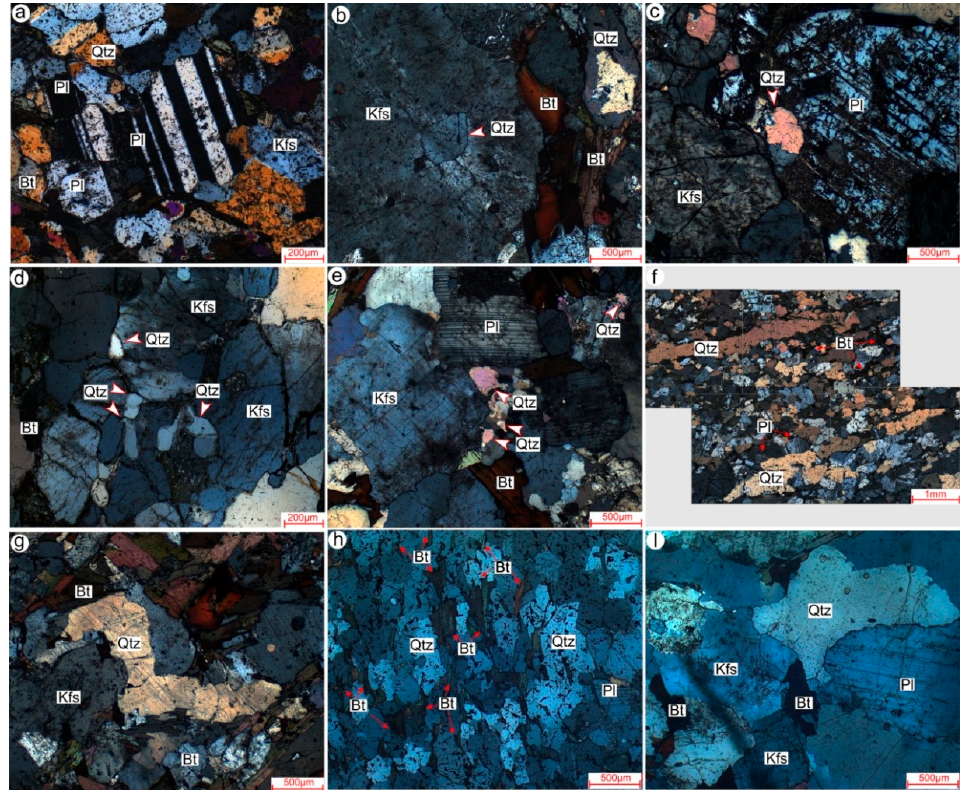
Figure 5. Microstructures of the Fuhuling metatexite, diatexite, and biotite monzogranite. ( a ) Microcracks in plagioclase in the metatexite. ( b,c ) Interstitial quartz at grain boundaries or within microcracks of K-feldspar in metatexites (arrows). ( d ) String of beads microstructure interstitial to quartz, K-feldspar, and plagioclase in the metatexite. ( e ) Interstitial quartz at triple junctions in diatexites (arrows). ( f ) Elongate quartz in the diatexite. ( g ) “Zig-zag type” quartz in the diatexite. ( h ) Oriented fine-grained biotite in the diatexite. ( i ) Representative photomicrograph of the medium- to coarse-grained biotite monzogranite. All photos are in crossed-polarized light. Abbreviations: Qtz—quartz; Kfs—K-feldspar; Pl—plagioclase; Bt—biotite.